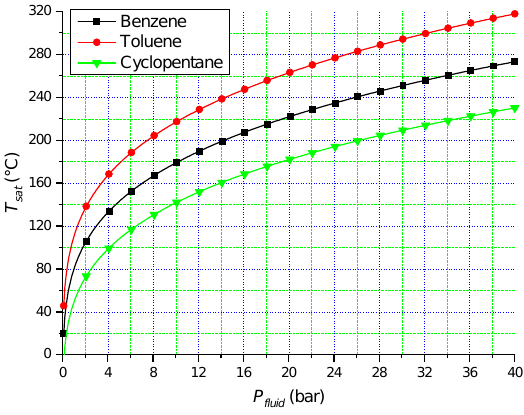
Figure 1. Saturation temperature vs. pressure for each organic fluid.